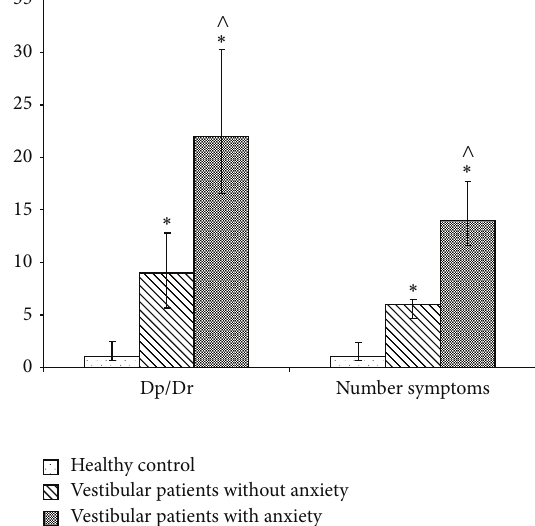
Figure 2: Median values and 95% confidence interval of Dp/Dr total score and number of symptoms for healthy subjects, vestibular patients without anxiety, and vestibular patients with anxiety. ∗ Significance between healthy subjects and vestibular patients, 𝑃 < 0.05 and ∧ significance between both vestibular patients groups, 𝑃 < 0.05 (Mann-Whitney 𝑈 test and Fisher’s exact test).